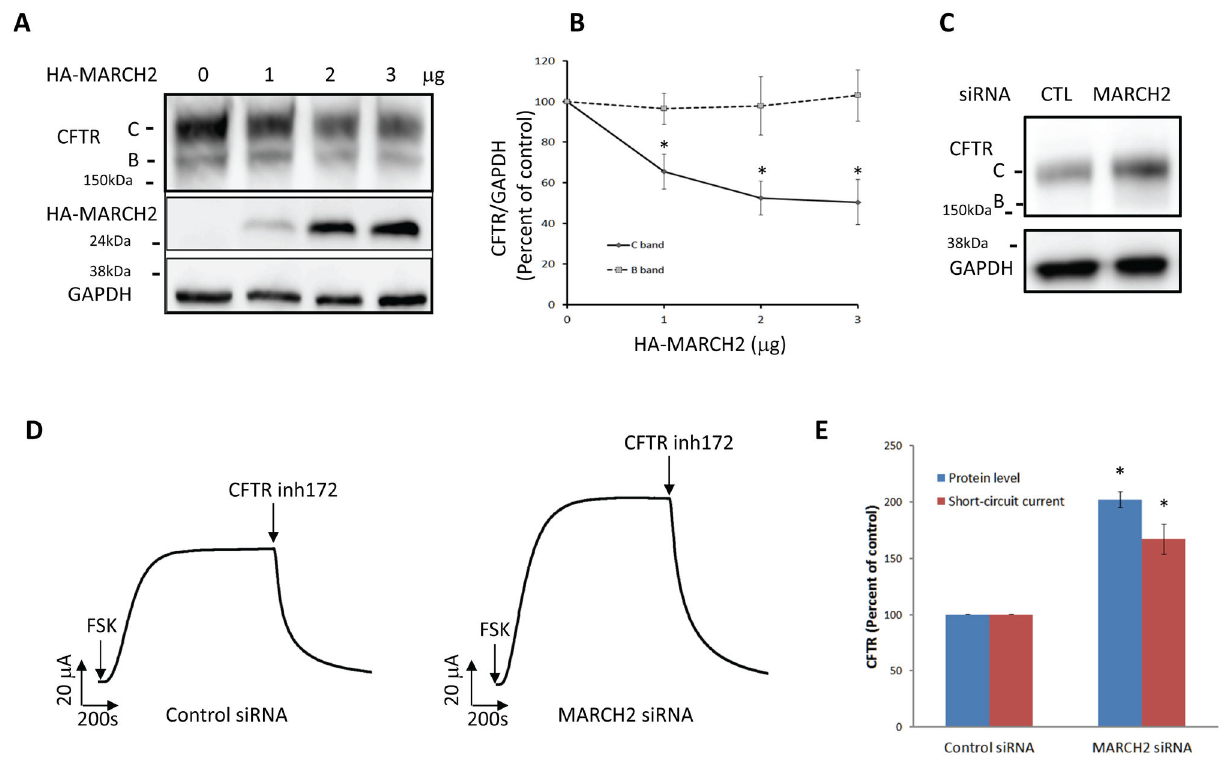
Figure 3. Effect of overexpression and silencing of MARCH2 on CFTR. ( A ) HEK293 cells were co-transfected with 3µg GFP- CFTR and increasing amounts of HA-MARCH2 (1µg, 2µg, and 3µg as indicated). After 48 h, cell lysates were harvested and subjected to immunoblot analysis with anti-CFTR, anti-HA, and anti-GAPDH antibodies. ( B ) Densitometric analysis of CFTR in (A). CFTR is normalized to GAPDH. Values are presented as mean +/- S.E. *, p<0.05 versus control (n=3) ( C ) CFBE-CFTR cells were transfected with 20 nM of negative control (CTL) siRNA (AllStars negative control siRNA) or MARCH2 siRNA (Hs_MARCH-II_1 FlexiTube siRNA) as indicated. After 72 h, cell lysates were collected and subjected to immunoblot analysis with the indicated antibodies. ( D ) CFBE-CFTR cells grown on permeable supports were transfected with 20 nM of negative control siRNA (AllStars negative control siRNA) or MARCH2 siRNA (Hs_MARCH-II_1 FlexiTube siRNA) as indicated. Seventy-two hours after transfection, cells were mounted on the Ussing chamber setup, where short-circuit currents were measured as described in Materials and Methods . In the graph, 10 µM forskolin (FSK) and 1 µM CFTRinh-172 were added as indicated. ( E ) Densitometric analysis of CFTR protein level in (C) and summary of the short-circuit currents in (D). Values are presented as mean +/- S.E. *, p<0.05 versus control